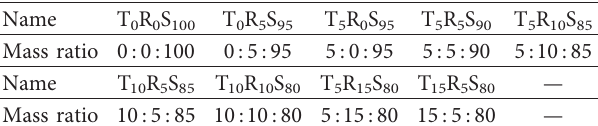
Figure 5: The additives used in the soil improving. (a) Tung oil. (b) Sticky rice juice. Table 2: 9 types of mass ratios of the treated soil specimens.